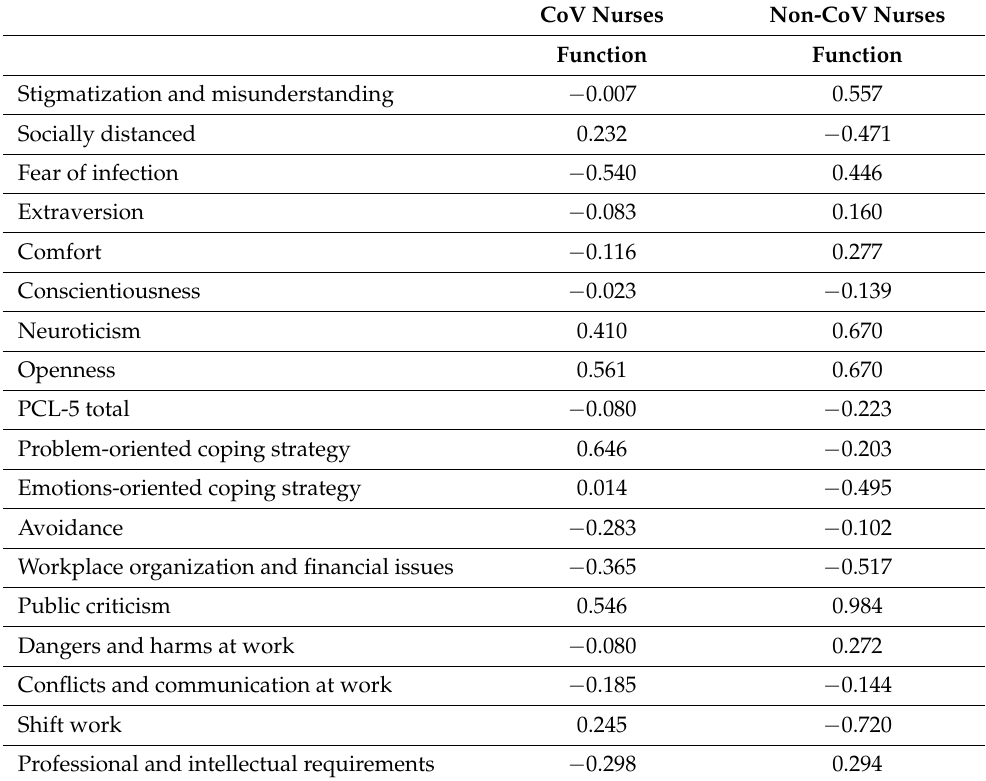
Table 4. Standardized canonical discriminant function